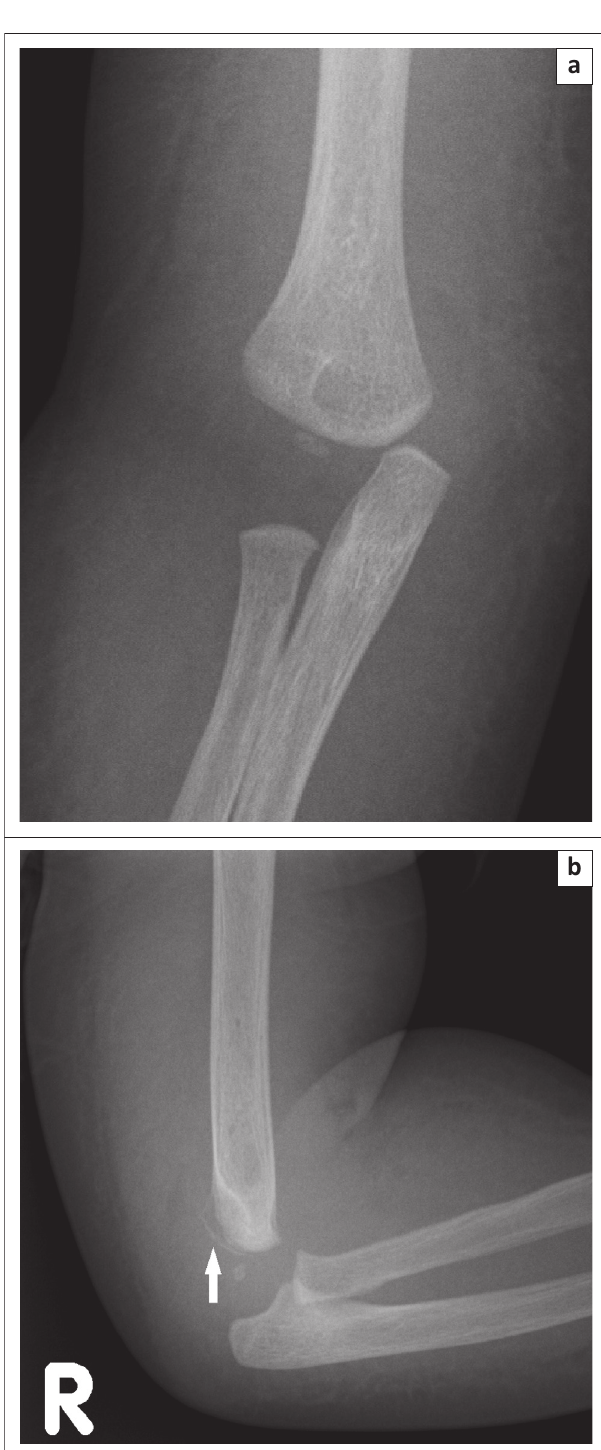
FIGURE 9: (a) AP and (b) Lateral views in a one-month-old with a swollen elbow who died soon after admission. Note the marked soft tissue swelling, the presence of a posterior fat pad and the bucket handle metaphyseal fracture. Multiple additional fractures were identified at post